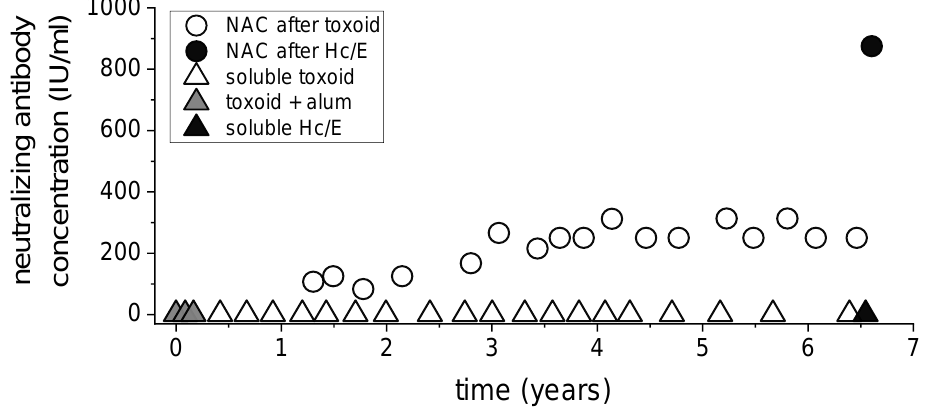
Figure 2. A boost with a high dose of recombinant H C /E dramatically elevates the NAC in a toxoid- immunized horse. Immunization schedule (triangles) and NAC (circles) in a horse immunized with 2 milligrams of type E botulinum toxoid over a period of 7 years. The first three immunizations (gray triangles) consisted of toxoid adsorbed to alum hydroxide, whereas all subsequent injections (white triangles) were with soluble toxoid. The NAC was determined in plasma collected three weeks after each boost. At the indicated time point, the horse was injected SC with a single elevated dose (40 mg) of recombinant Hc/E (black triangle). The neutralizing titer was measured in the plasma three weeks later and is indicated by a black circle.